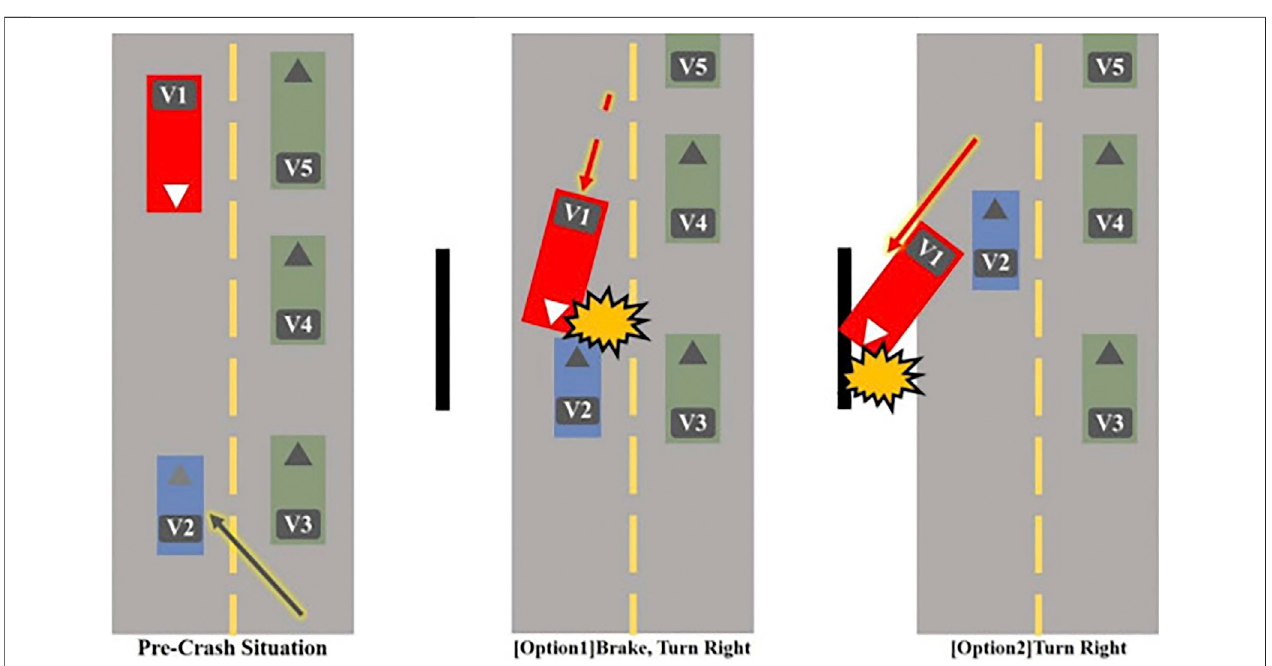
FIGURE 4 | AV moral dilemma: a rural two-lane road (source: Rhim et al., 2020, p. 45).